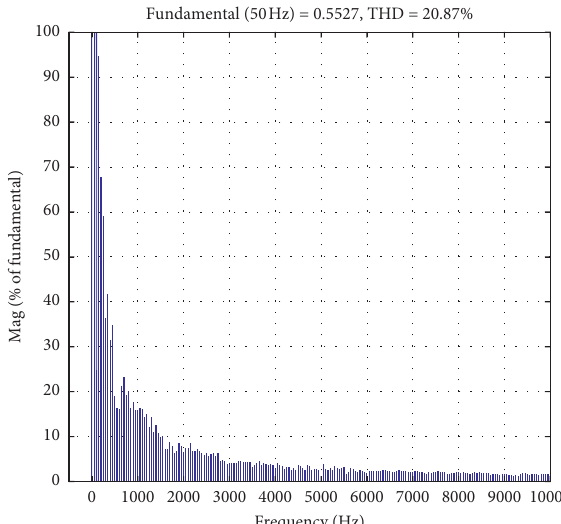
Figure 13: Spectrum analysis of electromagnetic torque using the Luenberger and the reduced-order observer.